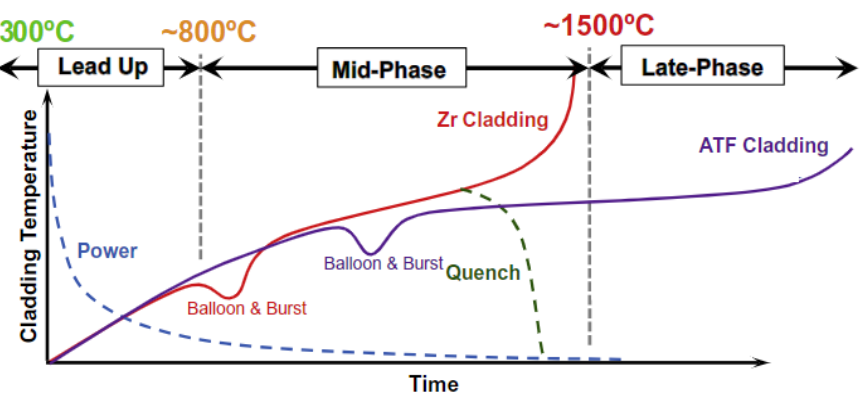
Figure 10. LWR accident evolution scenario for reference cladding and ATF cladding [2].